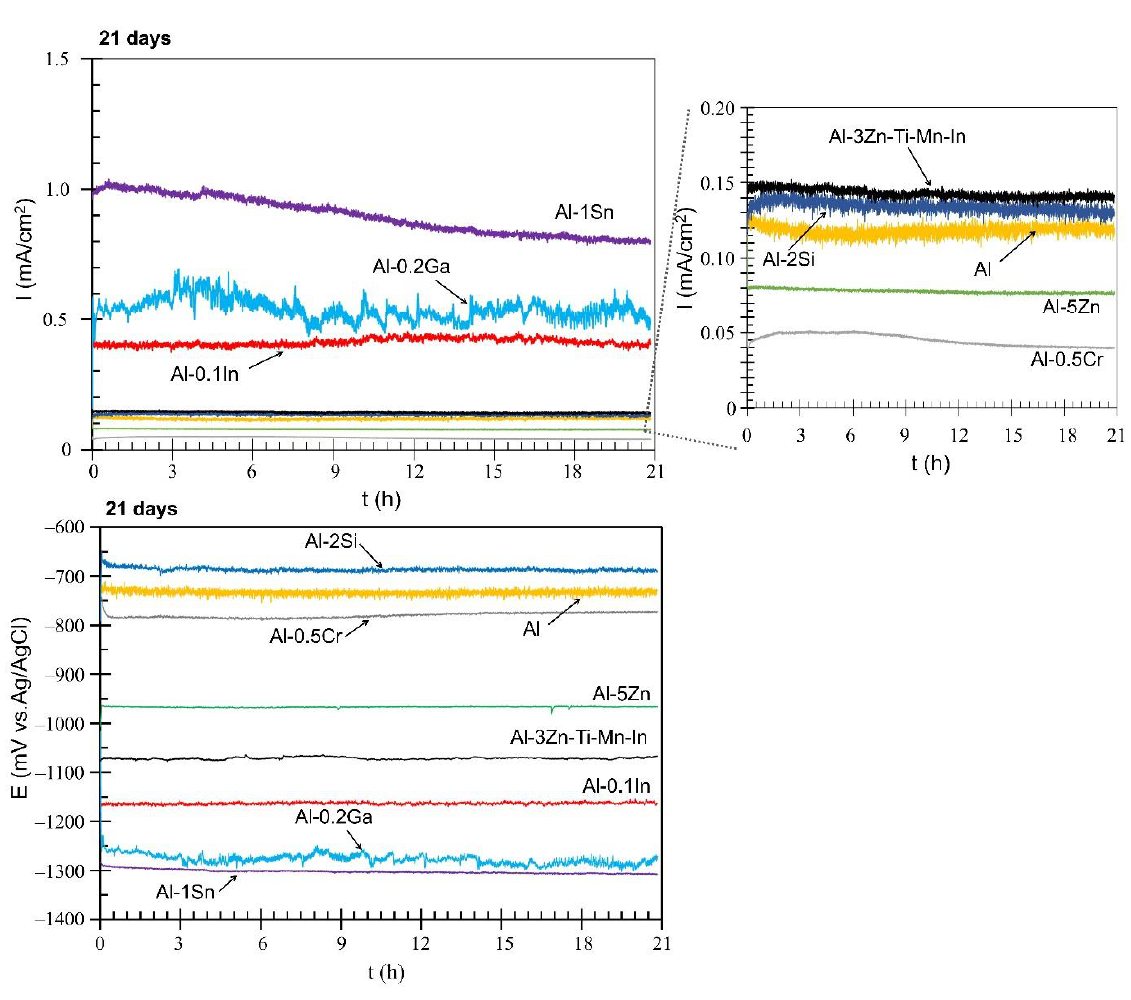
Figure 8. Galvanic current (I) and mixed potential (E) of the galvanic couple: mild steel and solution- treated Al-based alloys after 21 days. Table 5. Galvanic current and mixed potential (estimated and measured) of the solution-treated Al- based alloys vs. mild steel.